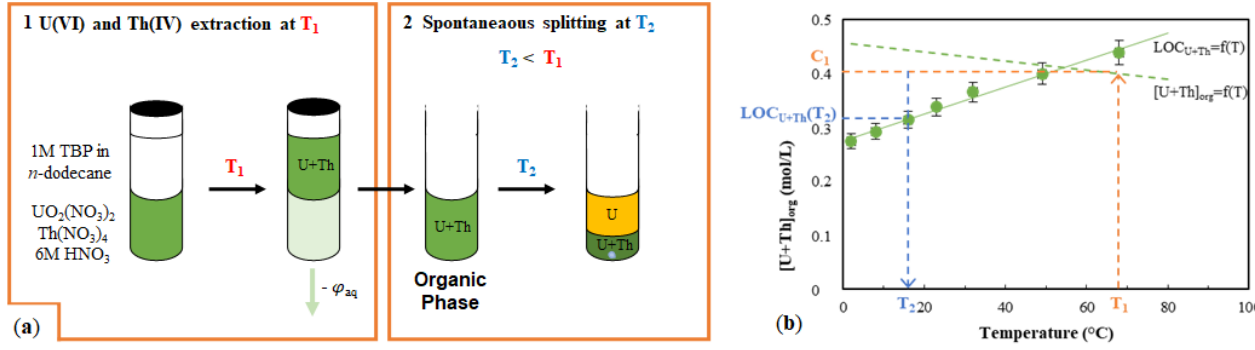
Figure 4. ( a ) Schematic diagram of organic phase splitting induced by temperature drop; ( b ) evolution of LOC and total extracted concentration of metallic ions in the organic phase according to